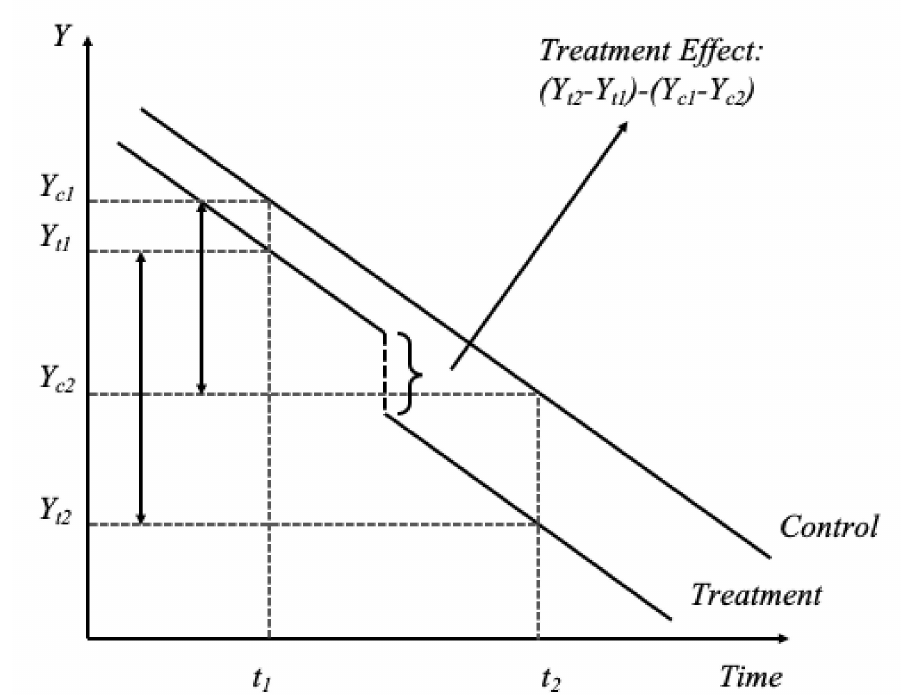
Figure 4. Spatial and temporal distribution of decoupling